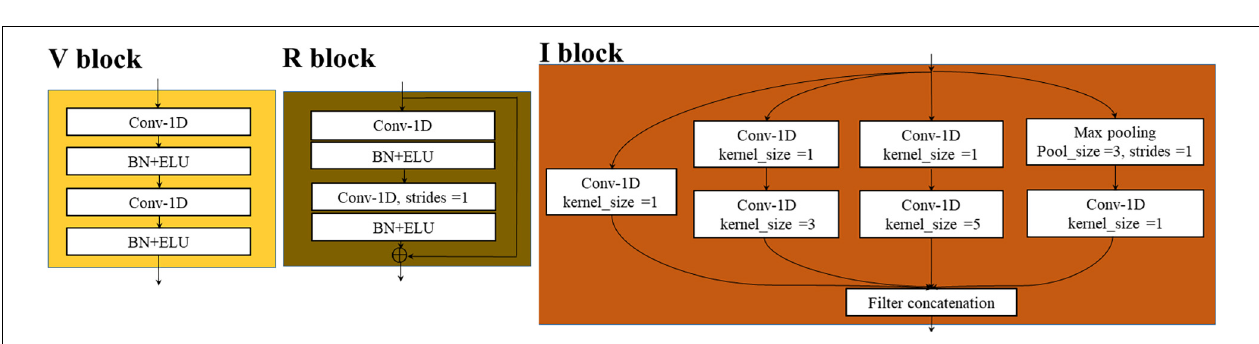
FIGURE 1 | The structures of three developed deep neural networks. The orange, brown, and red cubes represented the V block, R block, and I block in Figure 2 , respectively. The dark green and light green cubes represented the max-pooling layer and the average pooling layer, respectively. The yellow and blue cubes represented a one-dimensional convolutional layer, BN cascade activation function ELU, respectively. The striped bars represent flattened layers, and the light blue bars represented fully connected layers. The length, width, and height of the cubes and the bars in the Figure were drawn according to the dimensional size of data in each layer for a more intuitive display.